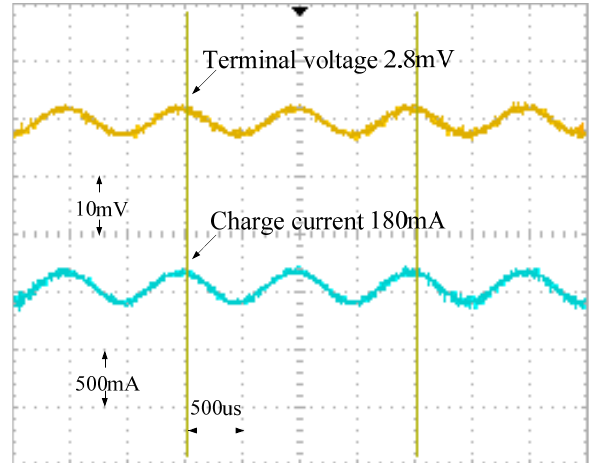
Figure 20. The charge current and the terminal voltage waveforms with DC components filtered at an SOC of